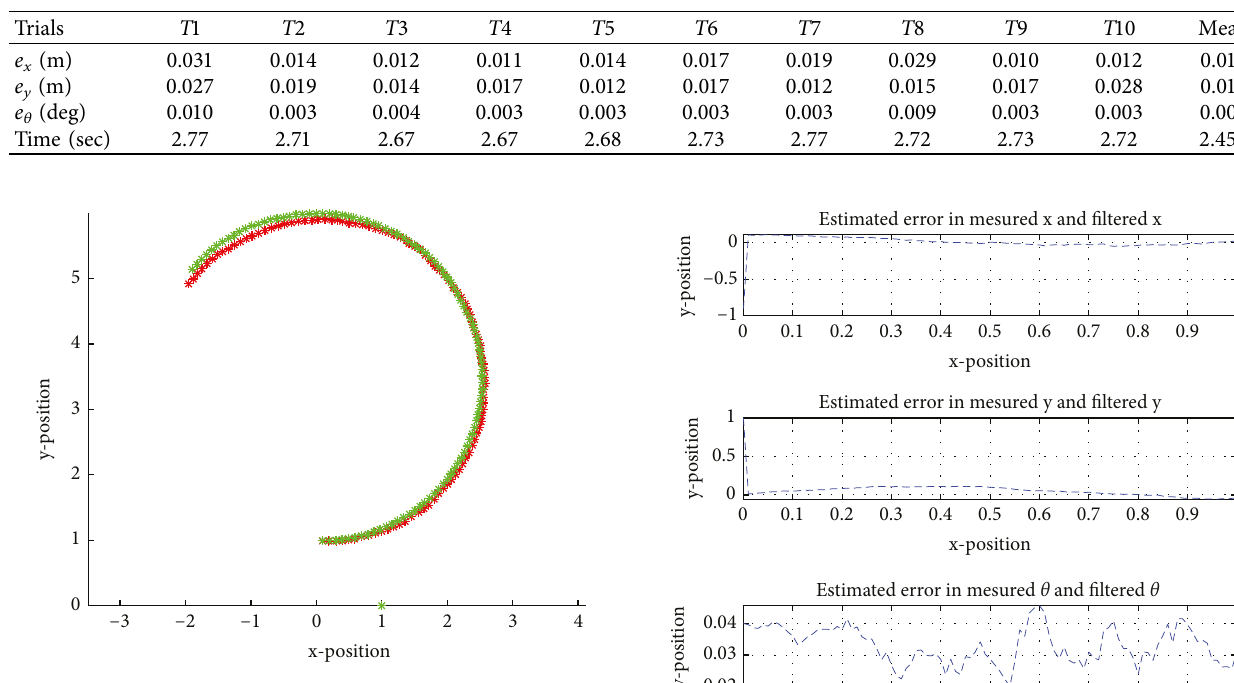
Table 10: The mean of the trials with the PF (one landmark and Gaussian noise).